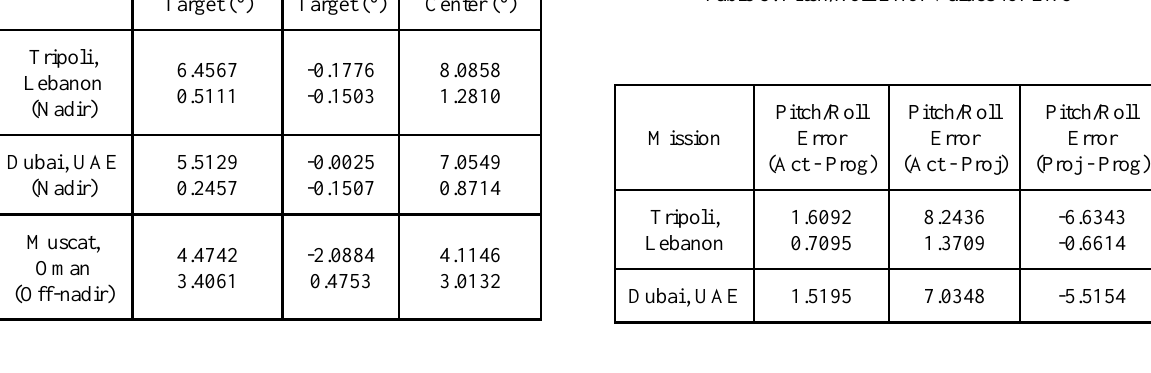
Table 3. Pitch/Roll Error Values for